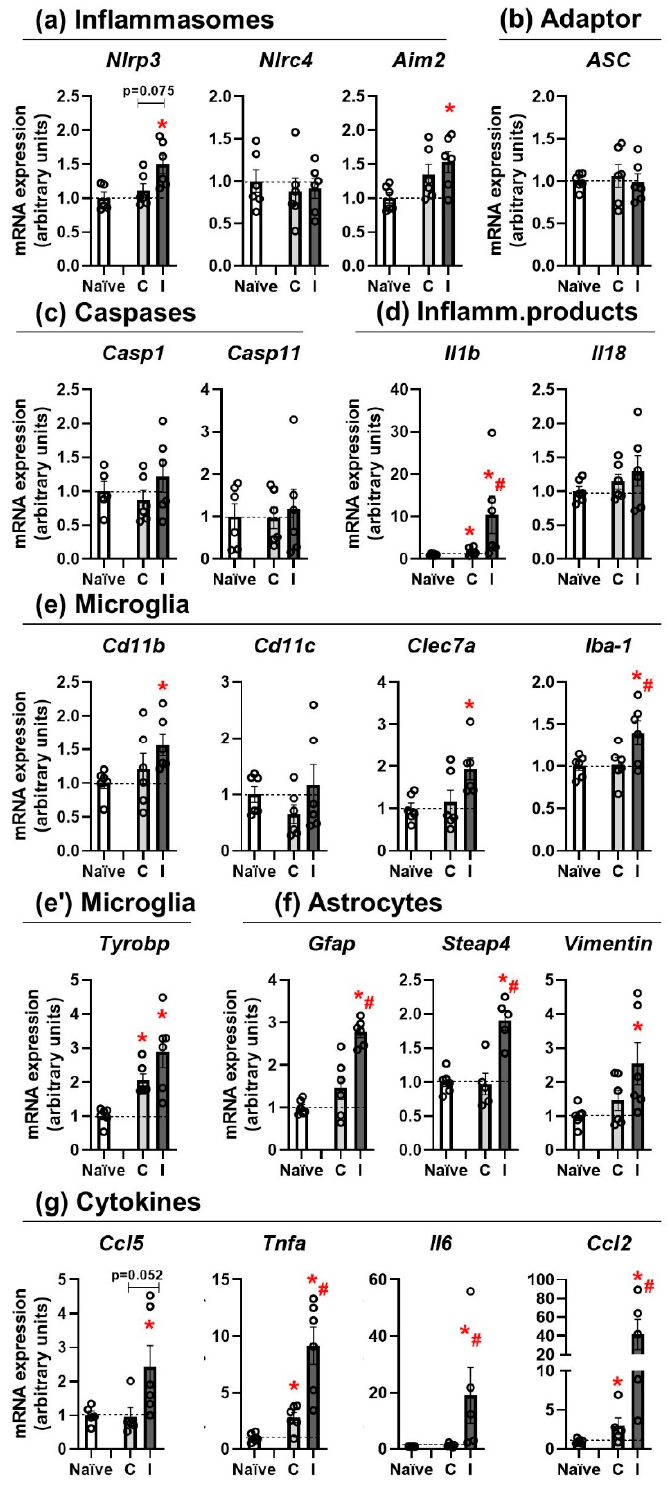
Figure 1. Inflammatory profile in WT 24 h after TBI. ( a ) Effects of lesion in inflammasome transcript expression. ( b ) Changes in the adaptor protein ASC. ( c ) Caspase 1 and 11 mRNA levels 24 after TBI. ( d ) Inflammasome product changes after lesion. ( e/e’ ) Microglia activation status after injury. ( f ) Activation markers of astrocytes 24 h after TBI. ( g ) Pro-inflammatory cytokine mRNA expression in naïve and injured animals. Mean ± SEM ( n = 6). Kruskal–Wallis or one-way ANOVA followed by Mann–Whitney or Bonferroni’s tests p ≤ 0.05. (* vs. Naïve; # vs. Contra). (C: contralateral; I: ipsilat- eral).